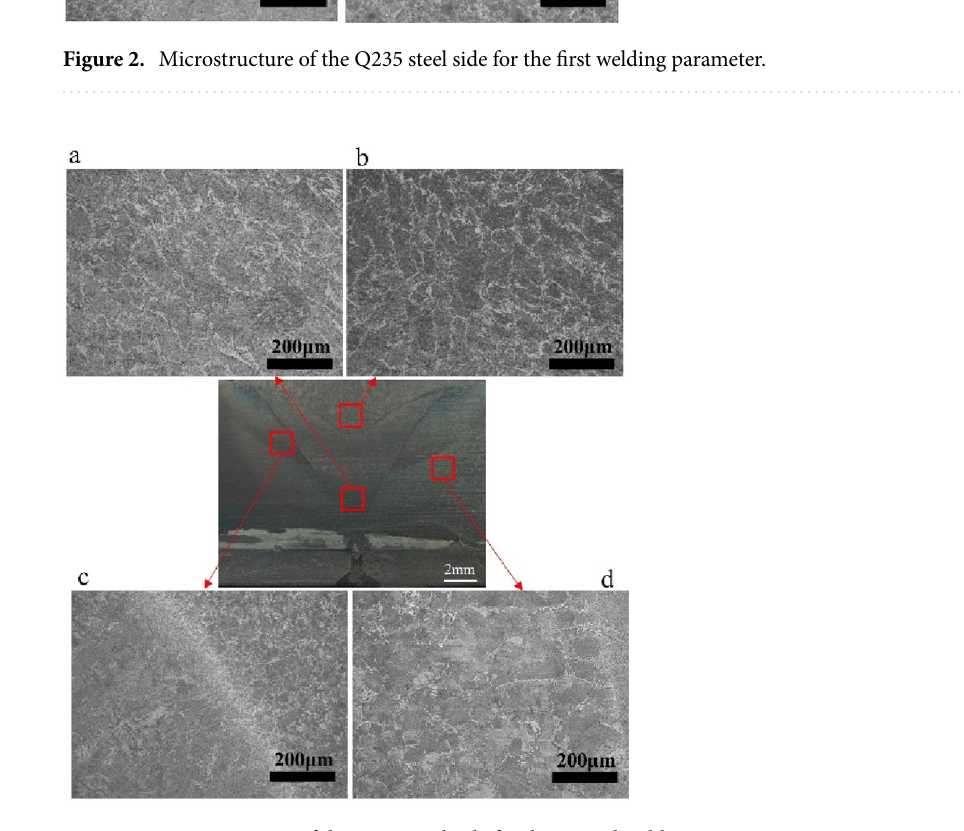
Figure 3. Microstructure of the Q235 steel side for the second welding